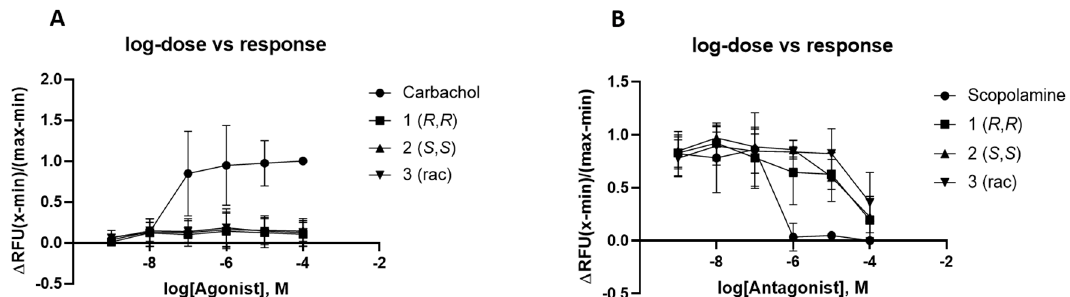
Figure 6. Dose-dependent calcium response to muscarinic 1 (M1) receptor agonists and antagonists. CHO-M1 cells were plated in black clear bottom 96-well plate and incubated overnight. The following day, cells were assayed for a calcium response to carbachol (positive control), 1 , 2 , and 3 using the Fluo-4 Direct ™ Calcium Assay Kit. Cells were stimulated for potential agonistic activity (panel A) [27] or cells were treated for potential antagonistic activity, scopolamine (positive control), 1 , 2 , and 3 to block the calcium response elicited by 20 µ M carbachol (panel B). Measurements are given in relative fluorescent units (RFU) as the maximum response minus the minimum response divided by the minimum